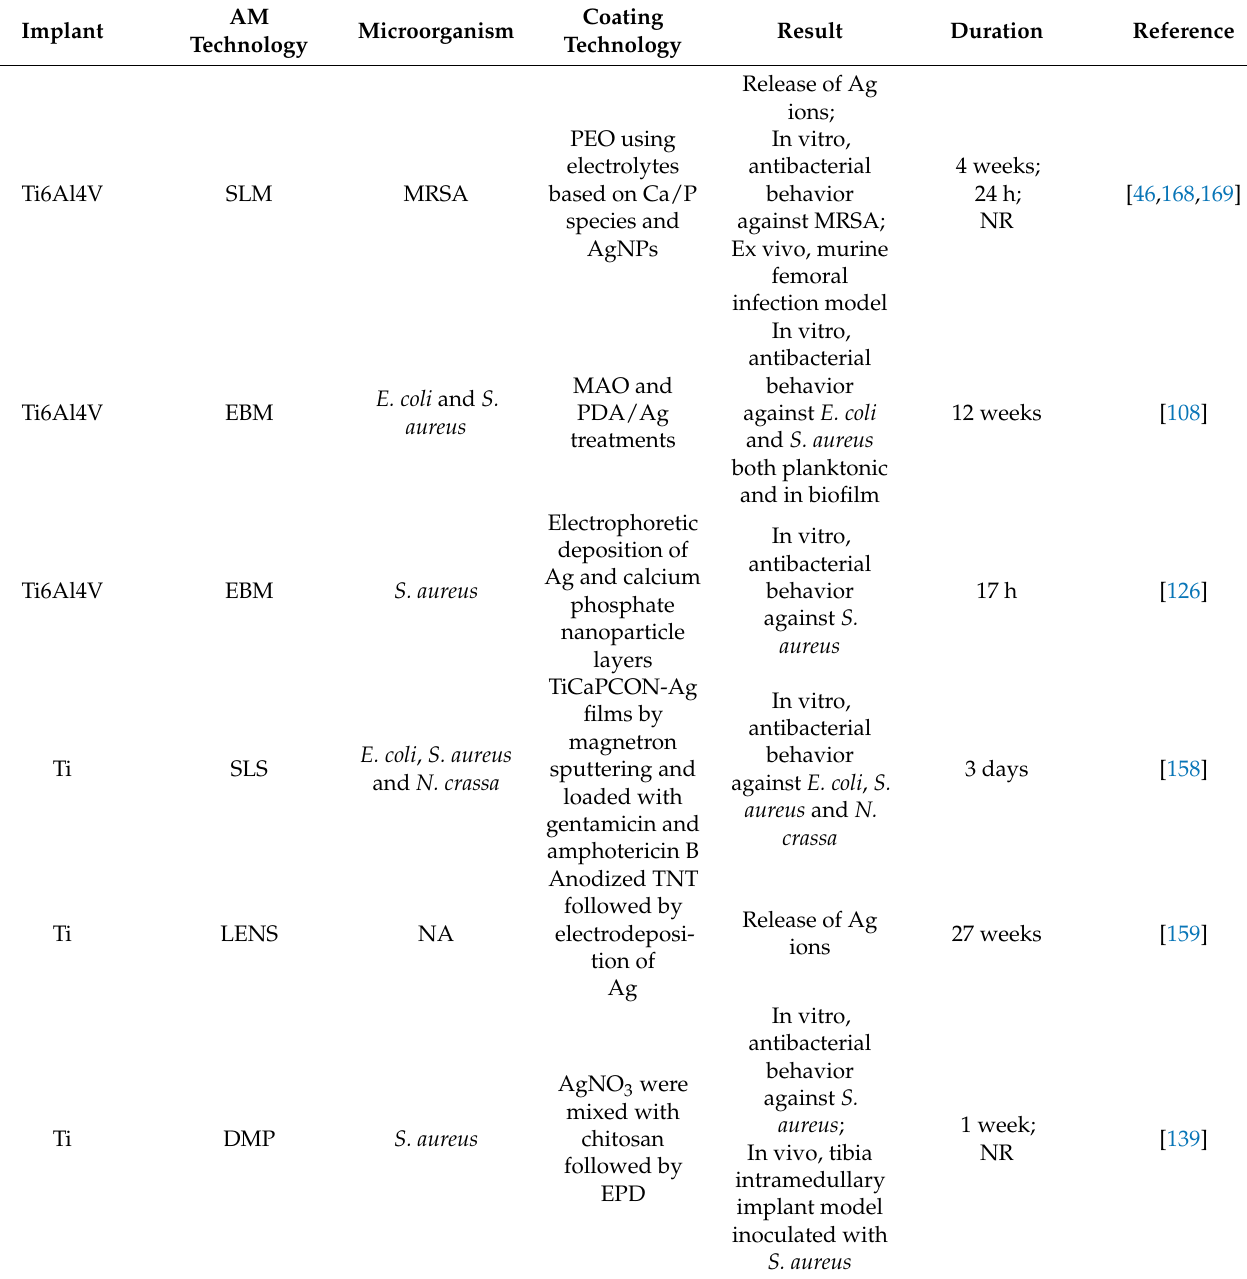
Table 1. The antibacterial effect of Ag coating prepared on AM